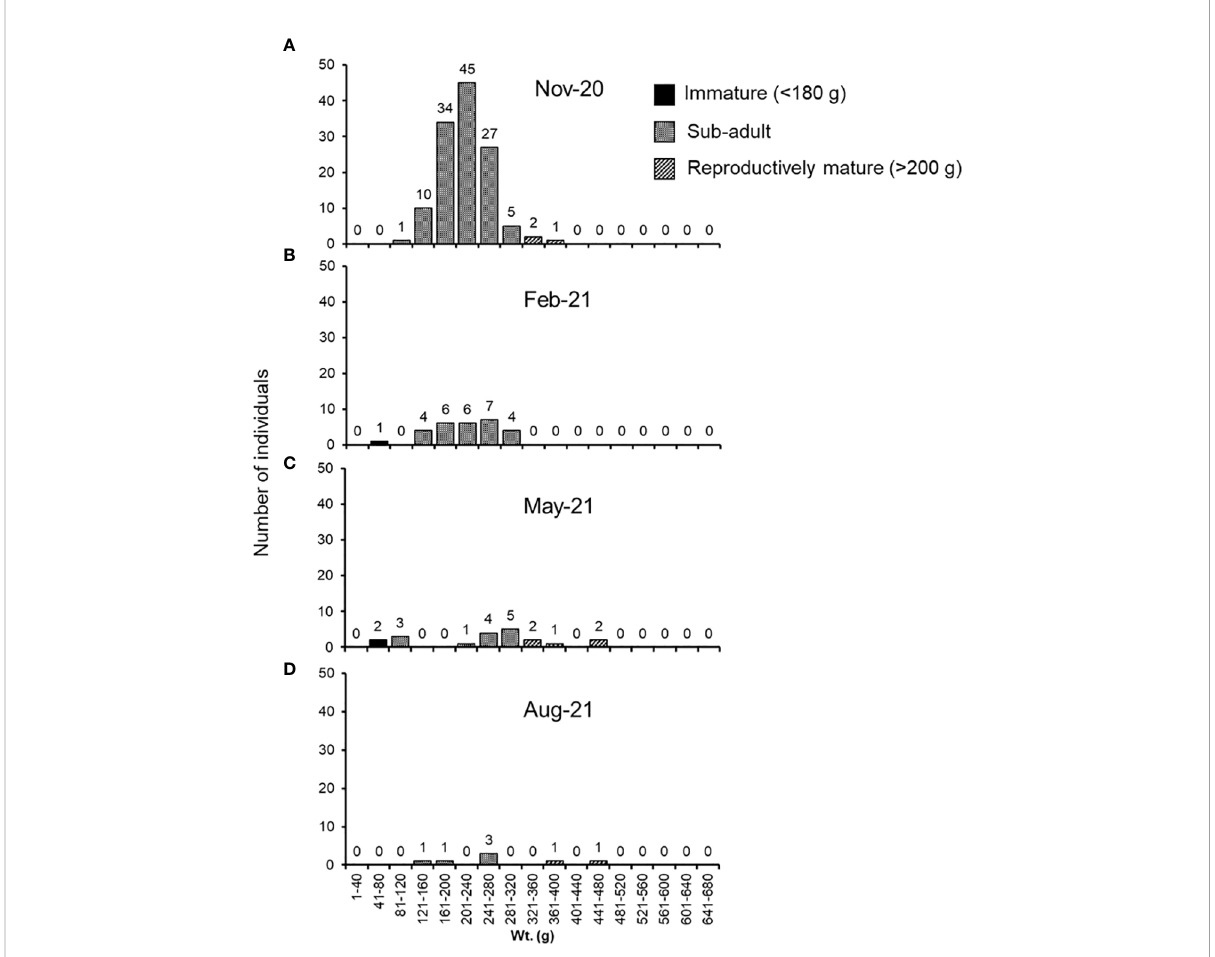
FIGURE 4 Size frequency distribution and total number of sand fi sh Holothuria scabra from the sea ranch during quarterly monitoring in (A) November 2020 (n = 125) before Typhoon Vancom hit Bolinao; and, (B – D) the total number of sand fi sh from the sea ranch during the quarterly monitoring in February 2021 (n = 28), May 2021 (20) and in August 2021 (n =7) following Typhoon Vancom, destruction of the guardhouse and reported poaching event within the sea